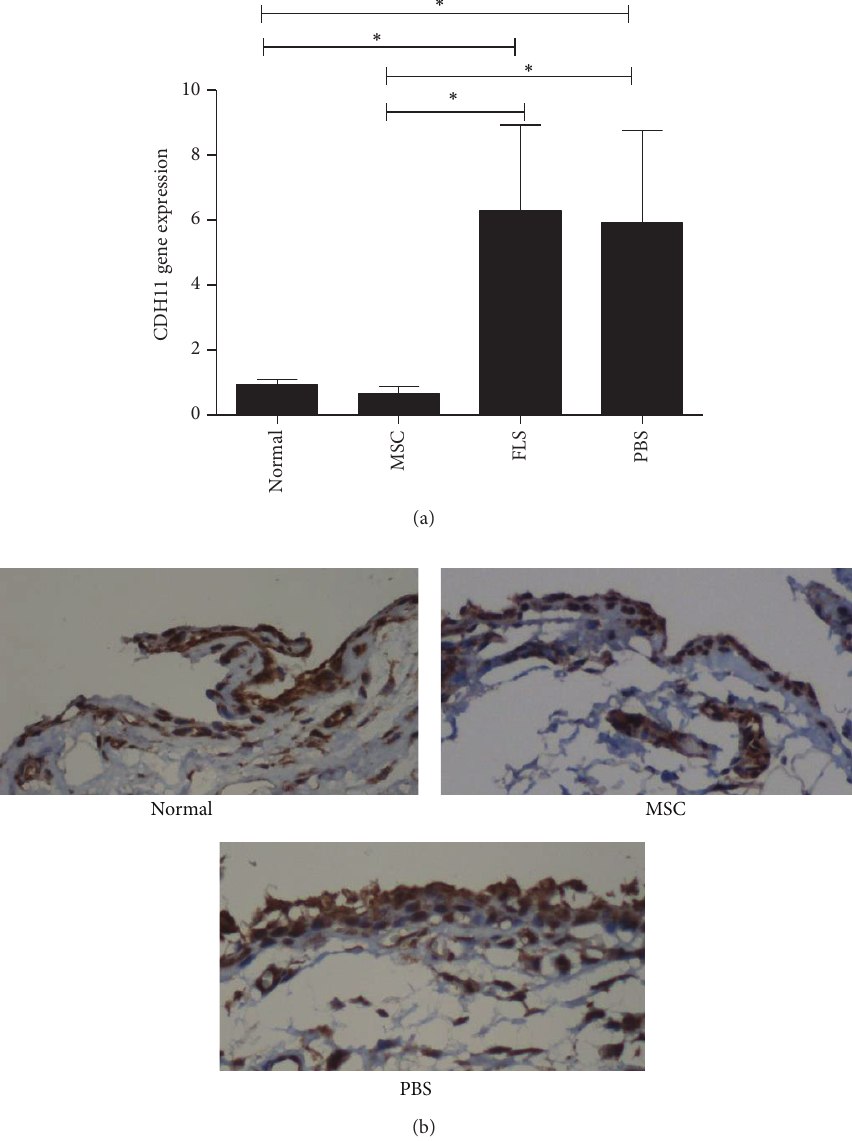
Figure 6: UCMSC transplantation inhibited expression of CDH11 induced by CIA in synovial tissue of rats. (a) Rats subjected to CIA were administered PBS, UCMSC, or fibroblasts. CDH11 mRNA levels in synovial tissues of rats subjected to CIA and administered UCMSC were similar to thosein synovial tissuesof normal rats, whereas which were lower than in thecontext of fibroblast or PBS administration. ∗ 𝑃 < 0.05 . (b) The expression of CDH11 increased remarkably in synovial tissues of rats subjected to CIA, whereas which decreased significantly after UCMSC transplantation. Magnification, 400x. UCMSC: umbilical cord-derived mesenchymal stem cell; CIA: collagen-induced arthritis; CDH11: